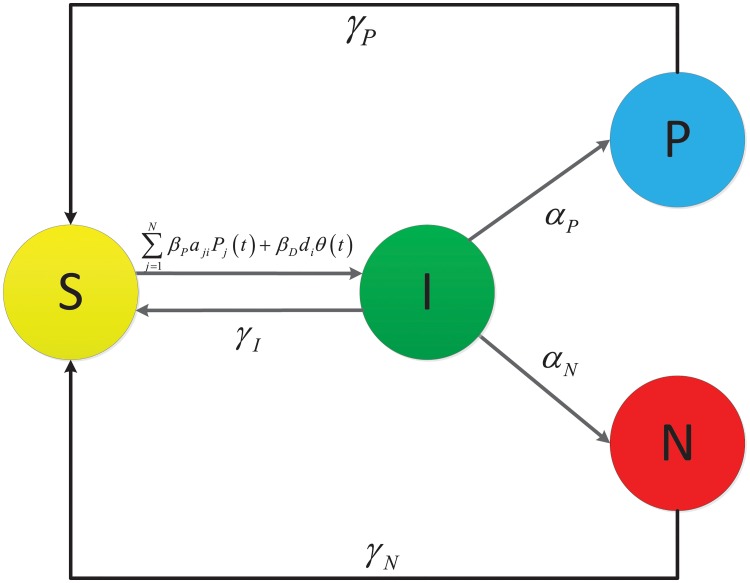
Diagram of state transitions of node i under the hypotheses (H1)-(H7).